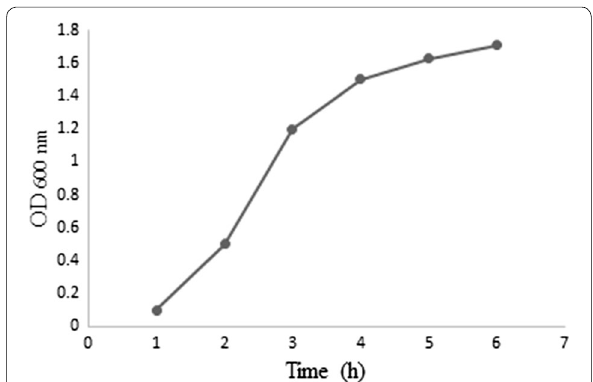
Fig. 3 Residual plot, internally Studentized residuals versus predicted